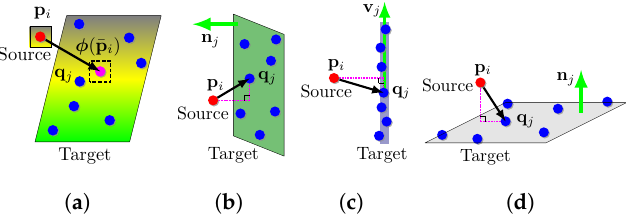
Figure 6. Overview of four different types of feature associations. ( a ) Reflector; ( b ) Facade; ( c ) Edge; ( d ) Ground feature